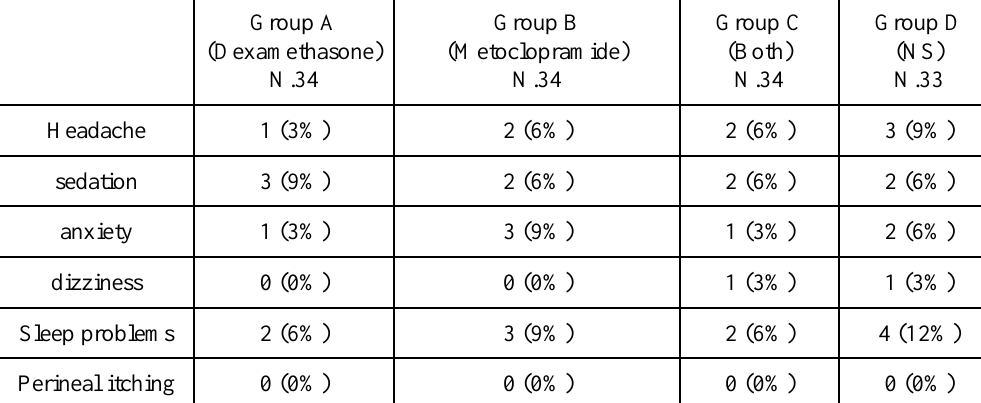
Table 4: Incidence of side effects